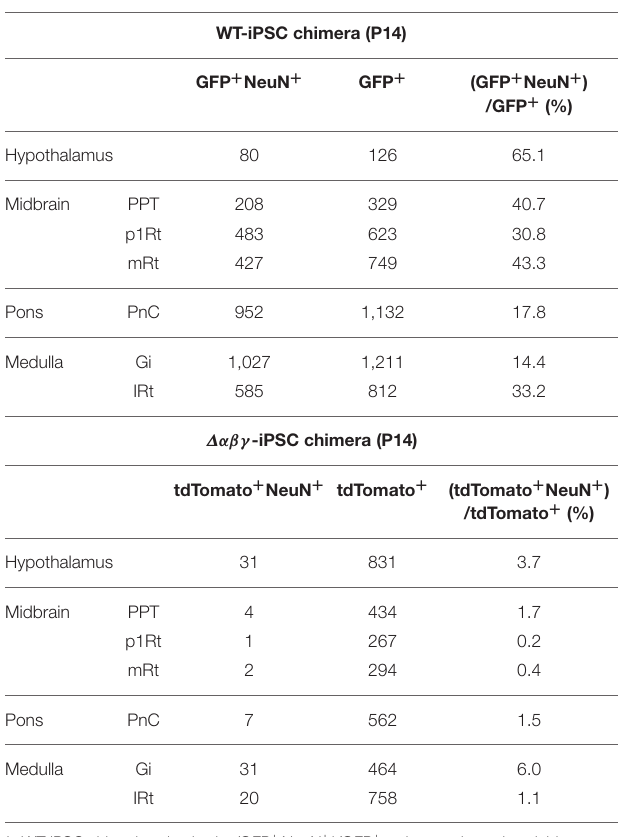
TABLE 1 | Survival ratio of chimeric populations (GFP + in the WT-iPSC chimera and tdTomato + in the ∆αβγ -iPSC chimera) and neuronal populations (NeuN + ) in the hypothalamus, midbrain, pons, and medulla of the WT-iPSC and ∆αβγ -iPSC chimeric mice.